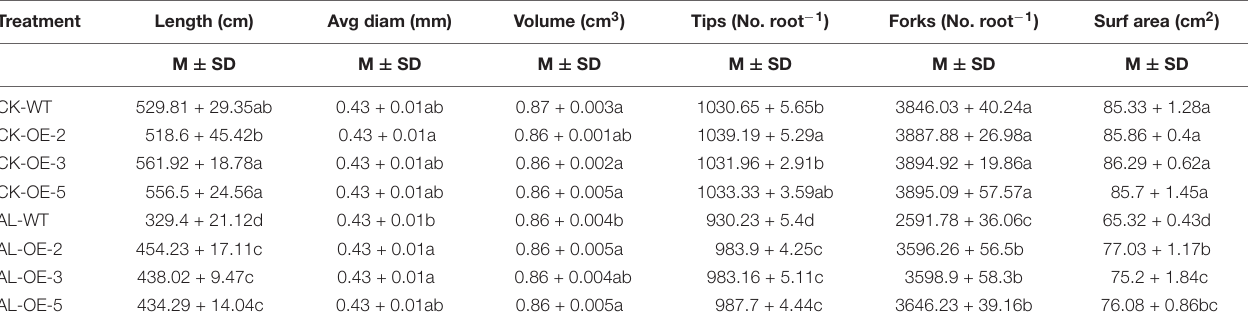
TABLE 2 | Root system architecture of MdTyDc -overexpression apple plants after 15 days under control and alkaline conditions.